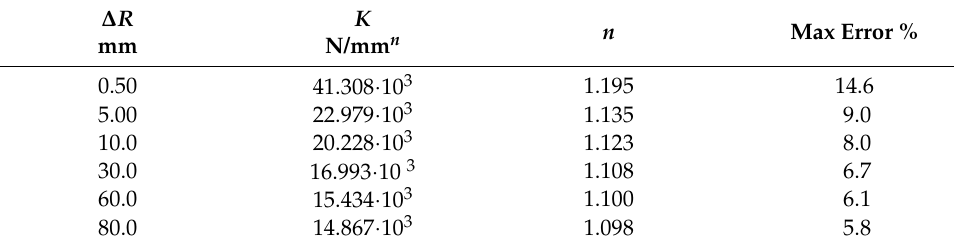
Table 3. Polynomial version of Radzimovsky’s [31] contact force model